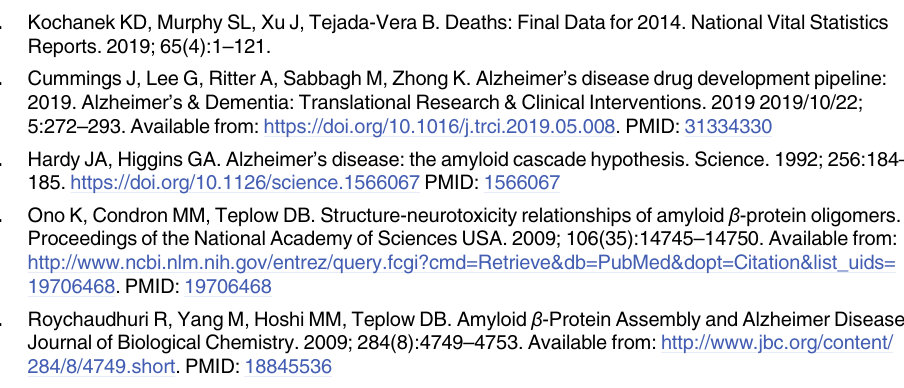
mean and the dashed lines represent the boundaries of the 95% confidence window. A/B : with U 0 fixed and static; C/D : with U 0 fixed and dynamic; E/F : with U 0 from example distribution and static; G/H : with U from example distribution and dynamic. Fig D : Stochastic Trajecto- 0 ries. A few random trajectories of prevalence and incidence for the entire population. A/B : with U fixed and static; C/D : with U fixed and dynamic; E/F : with U from the example distri- 0 0 0 bution and static; G/H : from U from example distribution and dynamic. Fig E : Incidence 0 Model. A : U fixed and static; B : U fixed and dynamic; C : U from example distribution and 0 0 0 static; D : U from example distribution and dynamic. Prevalence Model. E : U fixed and static; 0 0 F : U 0 fixed and dynamic; G : U 0 from example distribution and static; H : U 0 from example dis- tribution and dynamic. Incidence variation with ω . I : incidence for dynamic model with ω 0 0 varying. Fig F : Age-Dependent Toxicity. A : prevalence curve [19]. B : incidence curve [34]. C : HV curve.